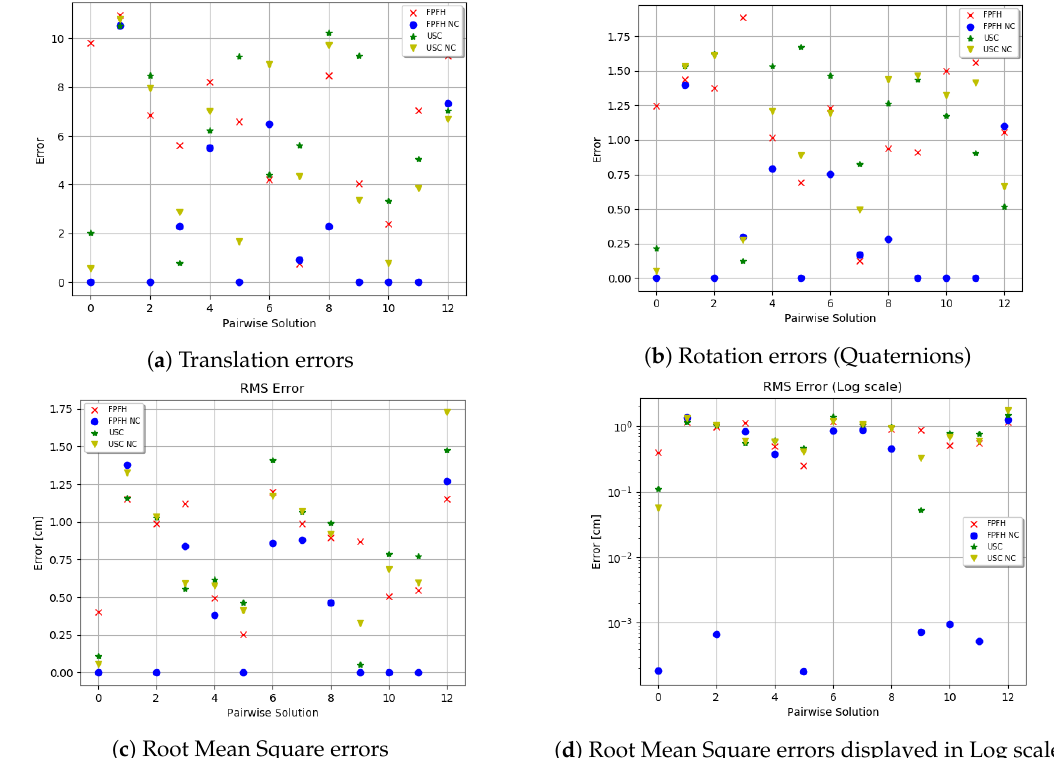
Figure 10. Evaluation of 3D rigid body transformations computed by matching USC and FPFH local descriptors based on multiple statistic errors. Additionally, the normal-based matching heuristics are included to highlight the positive impact of the proposed